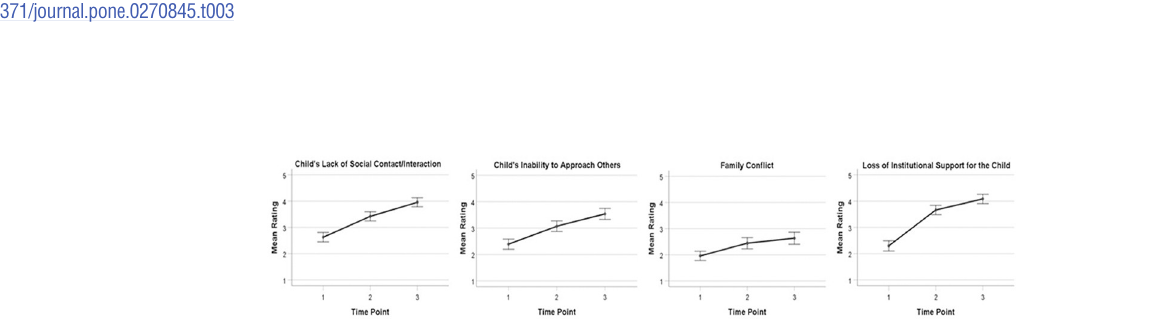
Fig 1. Line plots of estimated marginal means of the parent concern ratings. The plots demonstrate a significant linear change in all parent concern rating items over time. Time point 1: Before COVID-19; Time point 2: At the start of COVID-19; Time point 3: During COVID-19 (at the time of survey